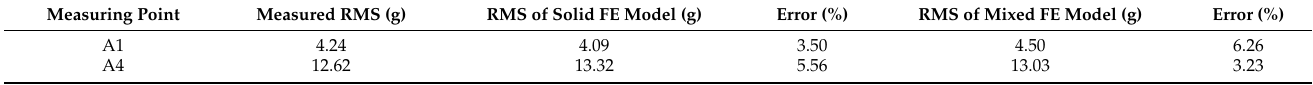
Figure 16. Calculated random vibration response of two FE models of experiment rack simulator. ( a ) Point A1 for solid FE model. ( b ) Point A1 for mixed FE model. ( c ) Point A4 for solid FE model. (d ) Point A4 for mixed FE model. Table 8. Random vibration test and simulation results of the experimental rack.